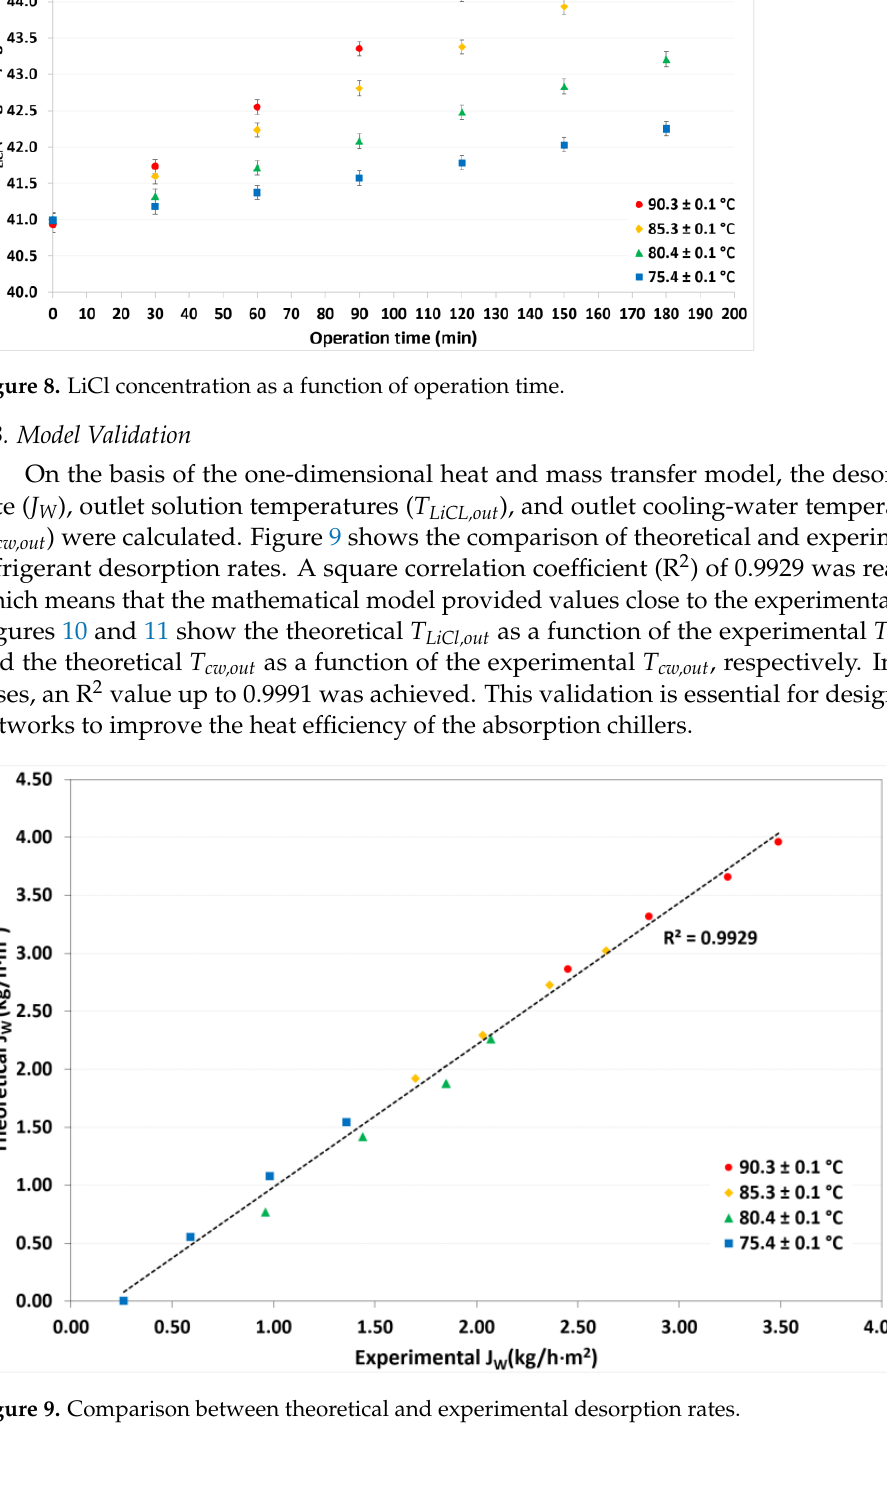
Figure 7. Refrigerant production as a function of operation time.